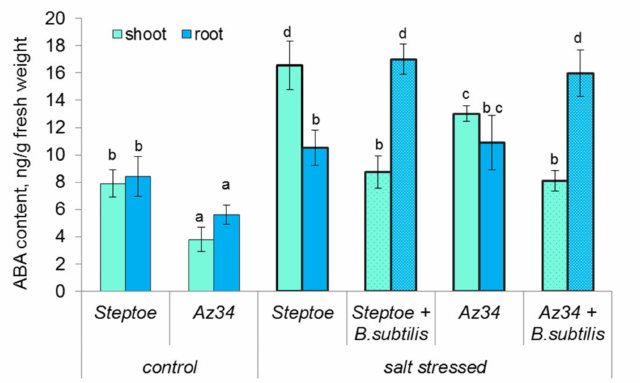
Figure 3. Influence of B. subtilis IB-22 on ABA content in shoots and roots of control (unstressed) and salt-stressed (100 mM NaCl) ABA-deficient barley mutant (Az34) and its parental cultivar Steptoe measured on the 8th day after bacterial treatment. Significantly different means are labeled with different letters at p ≤ 0.05, n =